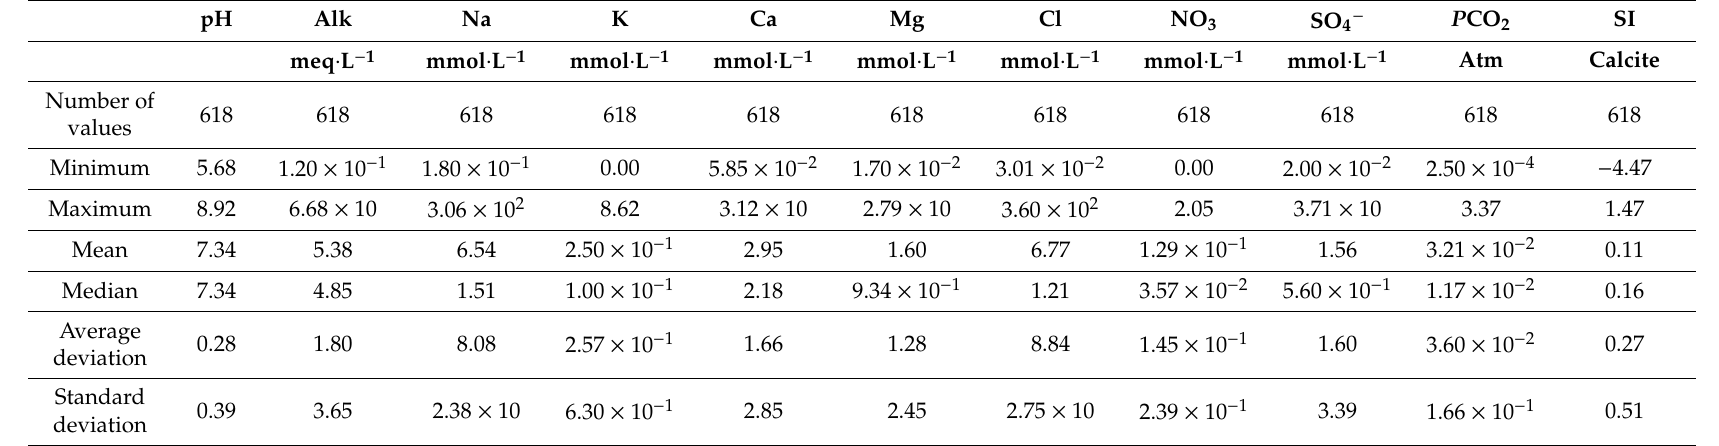
Table 1. Main statistical parameters of CO 2 partial pressure ( P CO 2 ), pH, saturation index, and major element